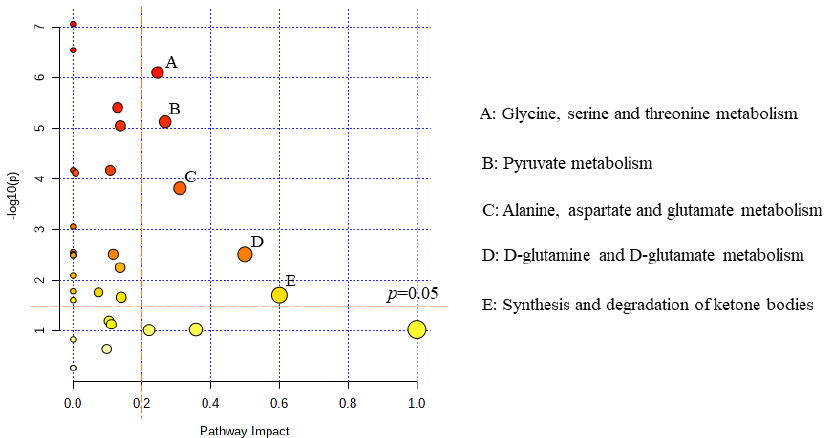
Figure 3. Metabolic pathway analysis for identifying significantly altered metabolic pathways in the PAH − CHD group relative to the CHD group. The vertical orange dashed line corresponds to the pathway impact value of 0.2 while the horizontal dashed line corresponds to the value of -log 10 ( p ) where p is equal to 0.05.